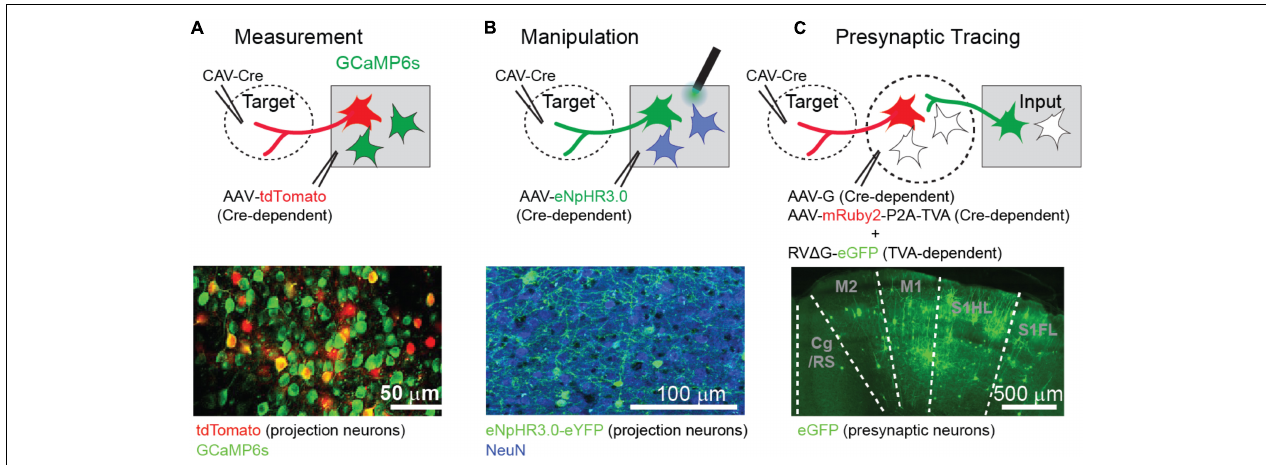
FIGURE 1 | Approachese to investigate long-range projection neurons. (A) Identification of projection neurons by retrograde labeling and two-photon calcium imaging. For instance, projection neurons can be labeled with tdTomato by combining Cre recombinase expressing retrograde virus (CAV-Cre) and Cre-dependent tdTomato expressing adeno-associated virus (AAV). Bottom image shows tdTomato expression in projection neurons (red) together with GCaMP6s expression in cells driven by the CaMKII promotor (green). (B) Suppression of projection neurons by an inhibitory light-sensitive ion pump, eNpHR. Similar to (A) , projection neurons can express eNpHR by the combined viral approach. Bottom image shows eNpHR expression in projection neurons (green) and neuronal nuclear protein NeuN signal (blue) in all neurons. (C) Monosynaptic retrograde tracing of neurons presynaptic to projection neurons. The first step is to express Cre recombinase only in long-range projection neurons. The Cre expression can be anatomically confined by injecting retrograde virus into the target area. In the second step, the projection neurons must attain the capability for infection of modified rabies virus and its trans-synaptic spread by expressing a specific receptor (TVA) and rabies glycoprotein (G). These two proteins are expressed by Cre-dependent AAV in the Cre-expressing projection neurons (red neurons in C ). The third step is to infect the projection neurons with pseudotyped, glycoprotein-deleted rabies virus, and to spread the rabies virus monosynaptically to presynaptic neurons brain-wide. Bottom image shows the remote input regions with GFP expression in long-range presynaptic neurons (green). All figures are modified from Hwang et al. (2019).